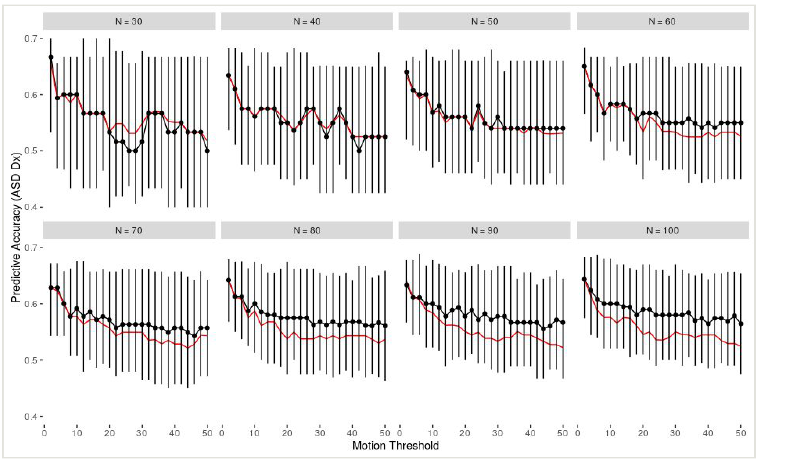
Figure 3. Out of sample prediction accuracy of autism diagnosis using resting state data as a function of sample size and motion-based exclusion criteria (percentage of fMRI, whole-brain volumes exceeding threshold). Red line is a naive classi fi er that assumes that all participants share the modal diagnosis (in this case, non-ASD). The black line spans the 5th to 95th percentile accuracy across iterations using a linear SVM, with the black points at the median value. Code and output can be found on GitHub (Flournoy and Leonard